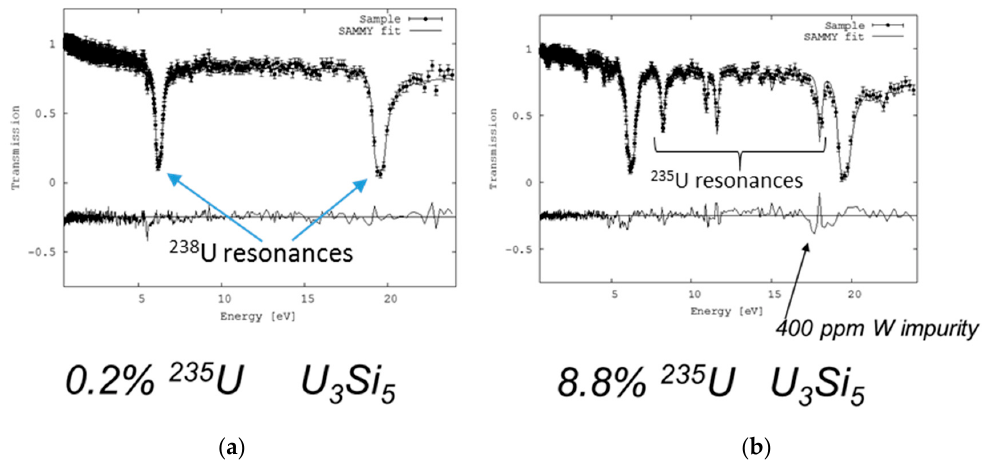
Figure 7. Examples of the transmission data analysis using the SAMMY code for two fuel samples with enrichment levels of 0.2% ( a ) and 8.8% 235 U ( b ).The difference curve between fit and experimental data is shown below.